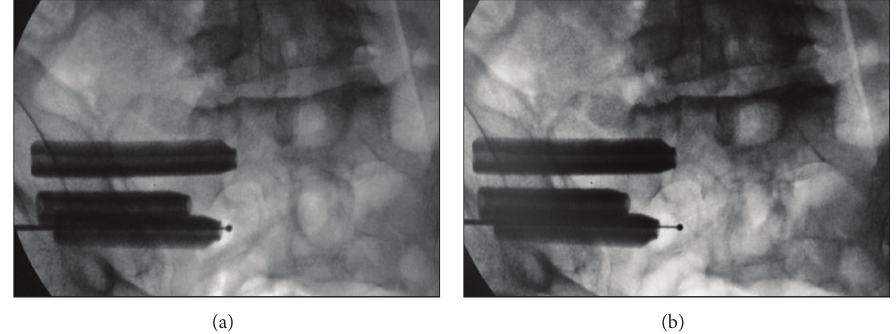
Figure 3: Following implant placement, the neuromonitoring probe is placed through the cannula of the implant and set to “searching” mode at 8 mA. In (a), monitoring of the probe past the distal end of the implant reveals a safe response, while further advancement of the probe to the position shown in (b) results in a positive EMG response, indicating that the probe has come within close proximity to a neural structure.